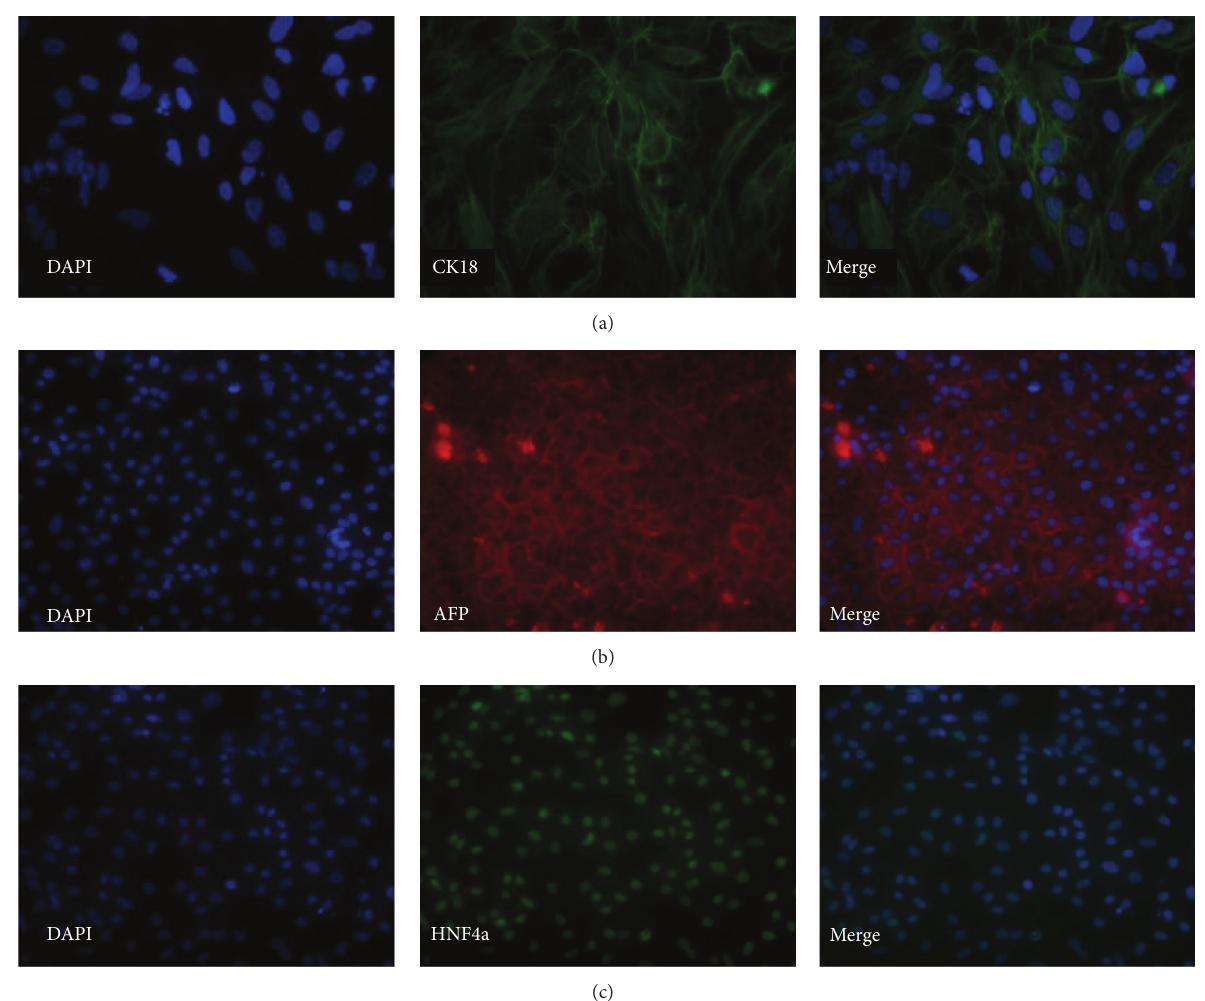
Figure 9: Representative micrographs illustrating the expression of selected markers at day 14 of the hepatic differentiation. Panel (a) shows staining for CK18 (SA121, 40x magnification). Panel (b) shows staining for AFP (AS034, 20x magnification). Panel (c) shows staining for HNF4a (AS034, 20x